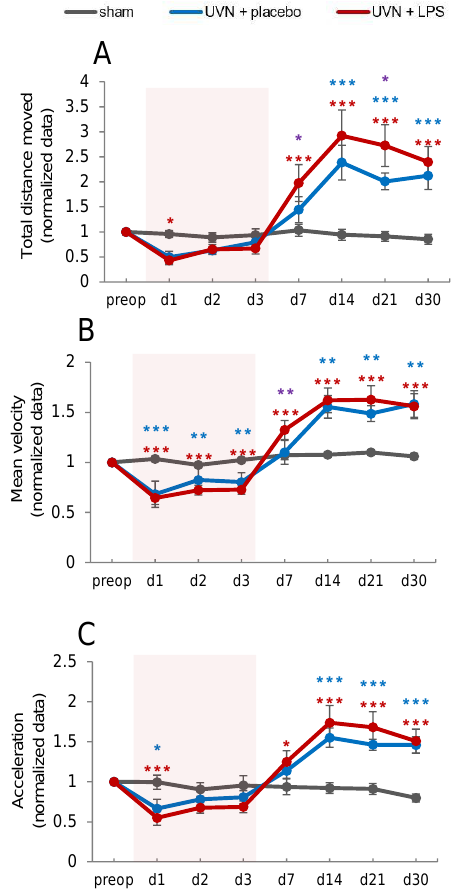
Figure 7. Acute LPS treatment has no impact on locomotor activity following UVN. ( A ) Evolution of the total distance moved. ( B ) Evolution of the mean velocity. ( C ) Evolution of the acceleration.